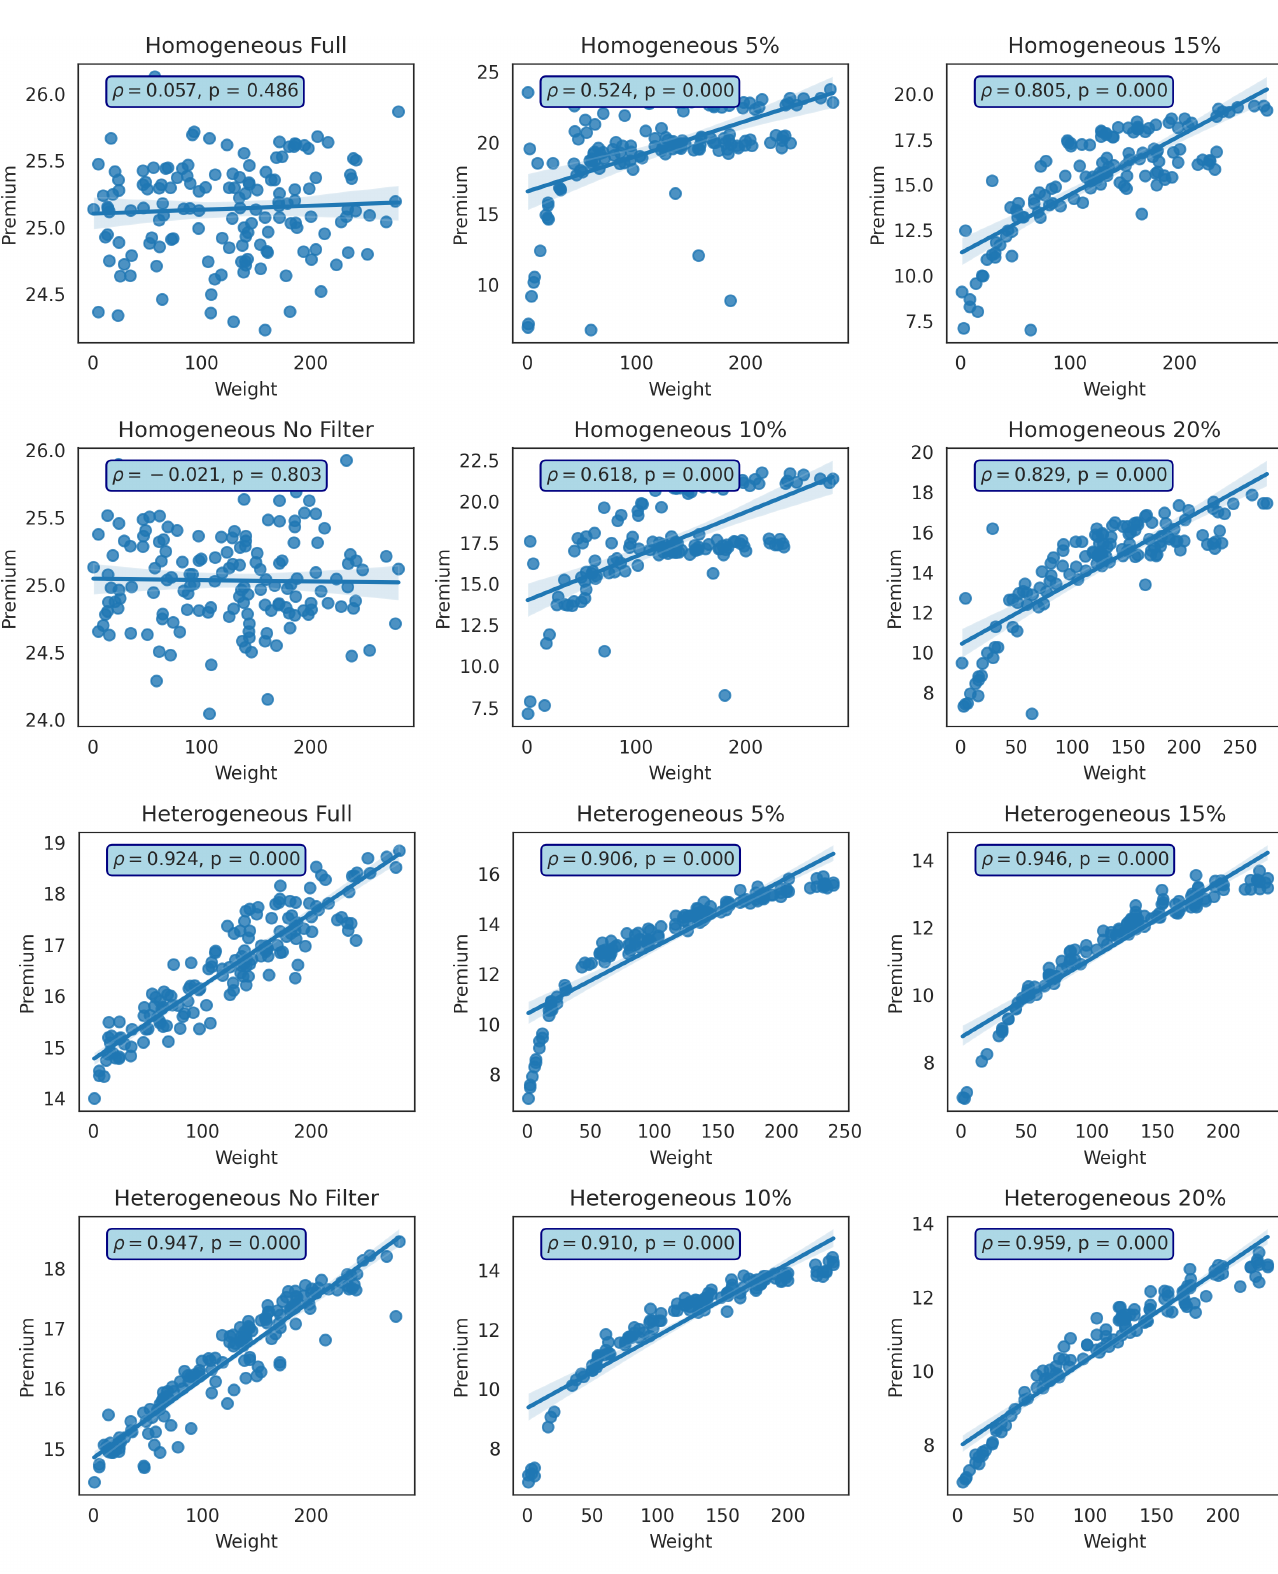
Figure 17. Relationship between the total weight of the neighbors and their premium (homogeneous and heterogeneous) for two cases: (1) without GMA (Full), and (2) with GMA (using filter 0% (No Filter), 5%, 10%, 15%, and 20% in the first network. ρ is the Pearson correlation coefficient and p is the probability